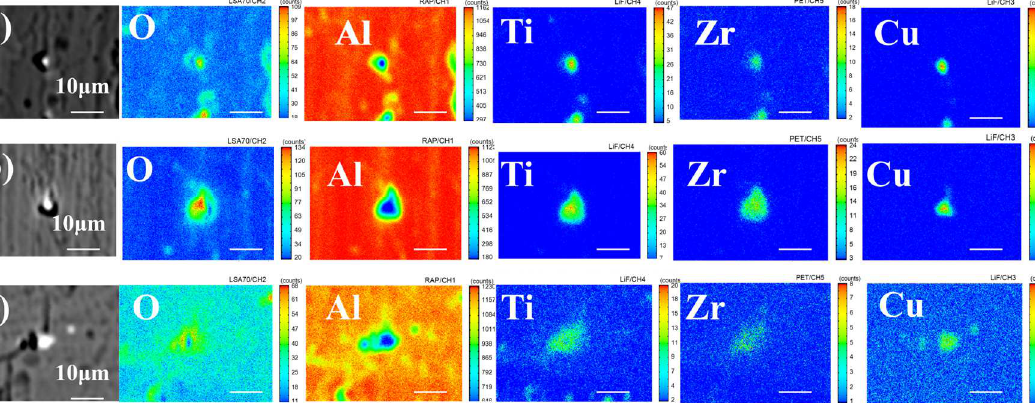
Figure 8. Results of EMPA of 7075 aluminum alloy with synchronous chemical conversion at different times: ( a ) at 100 s, ( b ) at 120 s, ( c ) at 140 s.